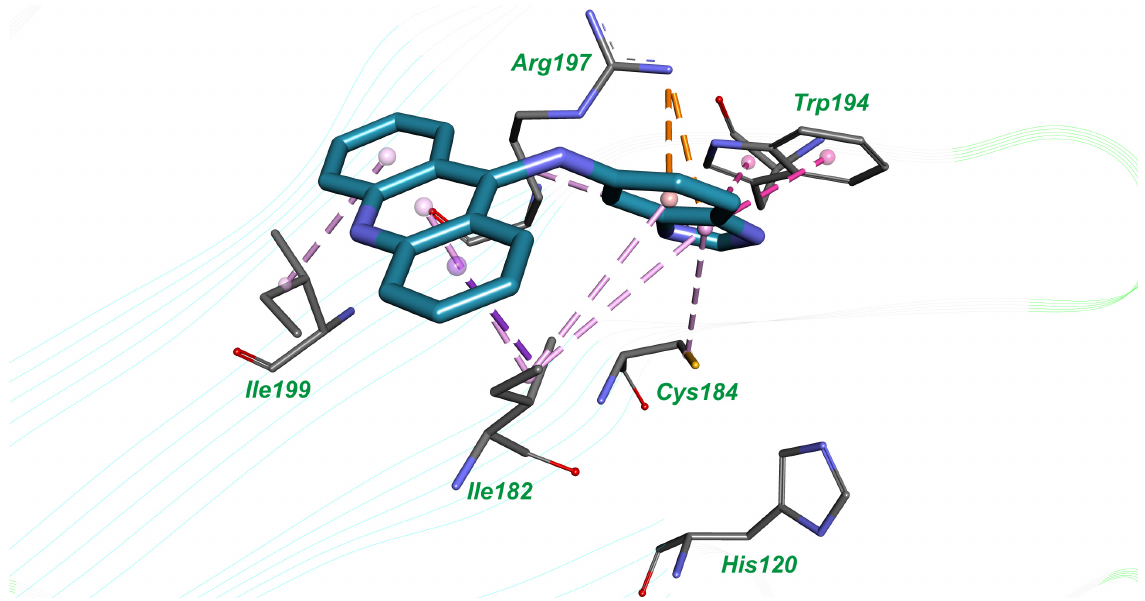
Figure 3. The binding mode of compound 2 in the active site of S. aureus sortase A; hydrogen bond is shown by the green dotted line, hydrophobic interactions are indicated by the magenta dotted lines and π -cation interactions are presented by the orange dotted lines. Table 2. The antimicrobial activity of compounds 1 and 2 toward multidrug resistant S. aureus